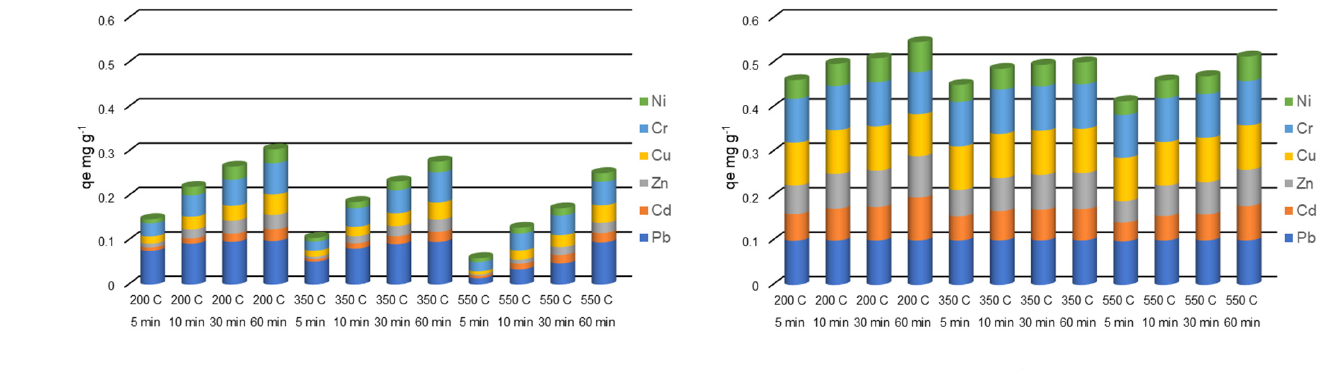
Figure 6. Heavy metals amount in the adsorbent phase q e (mg g − 1 ) with a grain size of 1–3 mm ( a ), and 0–0.05 mm ( b ), thermally treated adsorbed from multicomponent solutions of 10 mg L − 1 at four different contact times (5, 10, 30, 60 min).